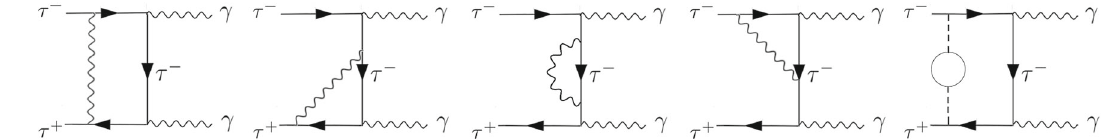
Fig. 4 RepresentativediagramsofNLOvirtualcorrectionsofthepara- ditauonium diphoton width. The first four diagrams show radiative vir- tual QED corrections, and the rightmost diagram represents the modi-